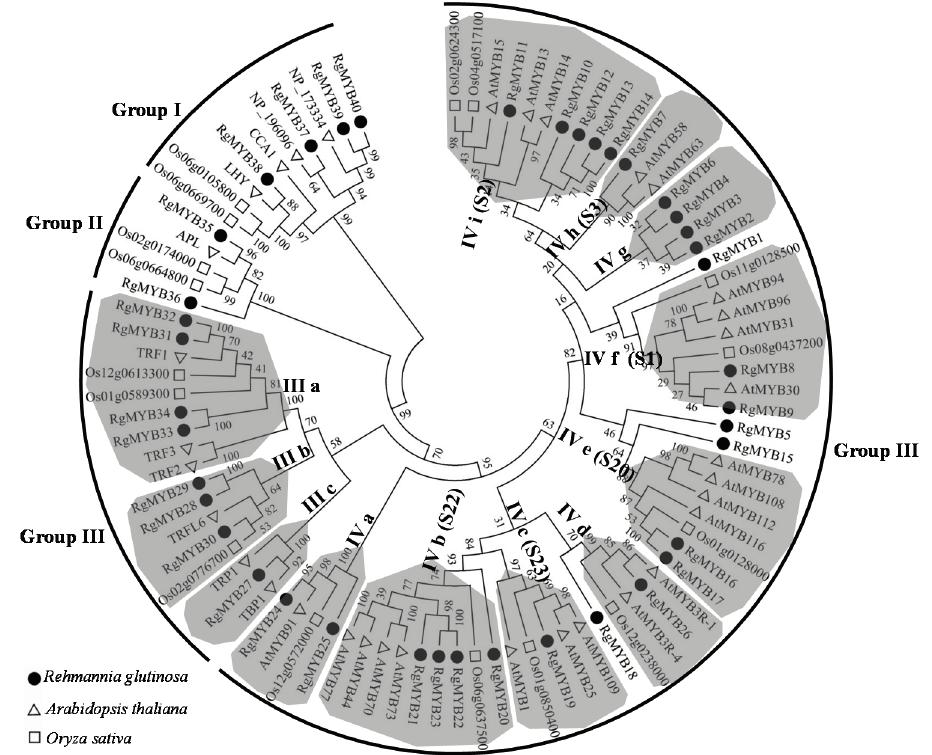
Figure 3. Phylogenetic tree of the MYB transcription factors from R. glutinosa , Arabidopsis and rice. The full-length sequences of the MYB proteins were aligned using MAFFT, and the phylogenetic tree was constructed using the neighbor-joining method in the MEGA6 software [46] (Tamura et al. , 2013). Bootstrap values (shown at the corresponding nodes) were obtained from 1000 replicates and are reported as percentages. The colored shadow marks the subgroups of the